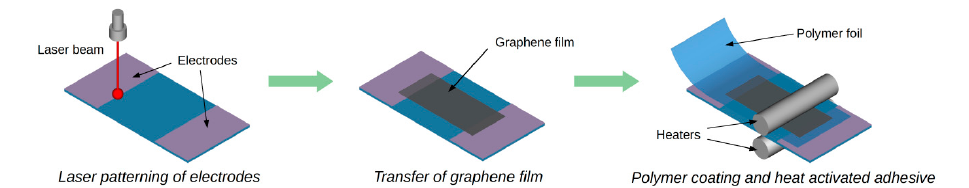
Figure 3. Method of manufacturing graphene cryogenic temperature sensor.